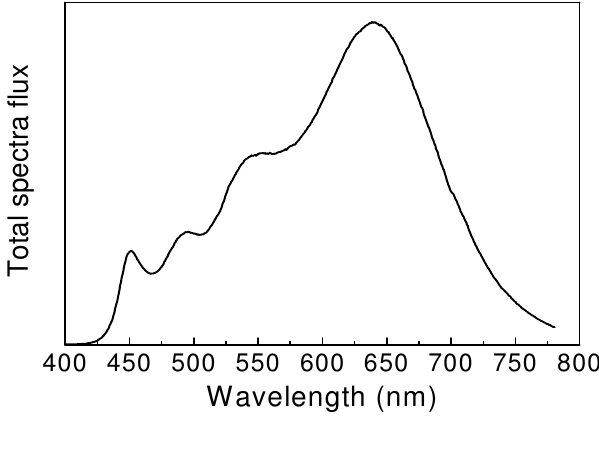
Figure 7. Emission spectrum of 4-pc white LEDs. The color rendering index Ra is 96, and the color temperature is 2800